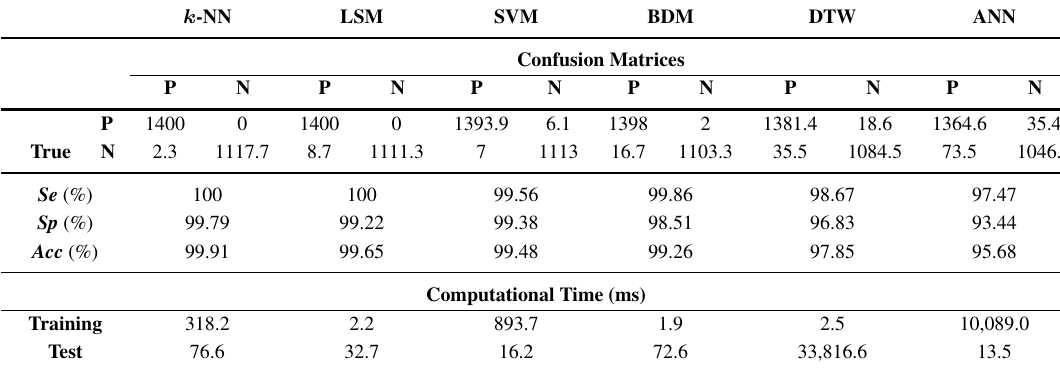
Table 2. Comparison of the results and the computational requirements of the six machine learning techniques in terms of the training and testing times for a single fold (P: positive, N: